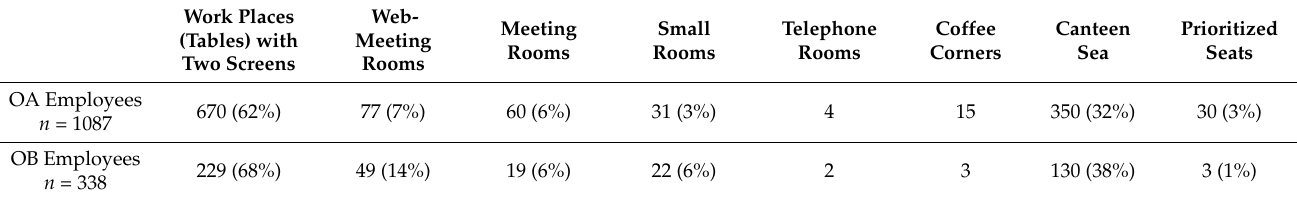
Table 2. Supporting work places, rooms, coffee corners, and canteen seats in OA and OB after relocation to ABW. The percentages relate to the total number of employees in the